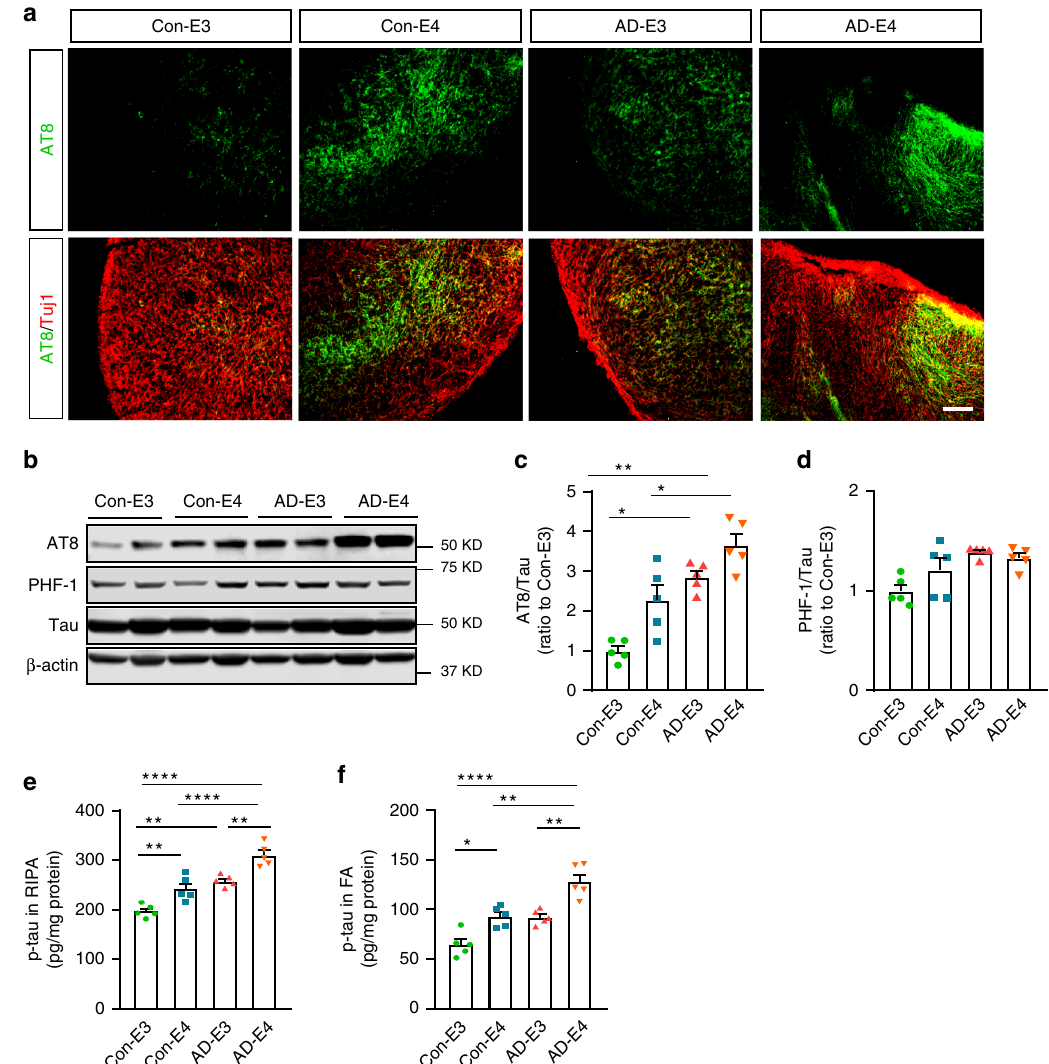
Fig. 4 APOE4 and AD status enhance p-tau levels in iPSC-derived cerebral organoids. Cerebral organoids were subjected to analyses by immunostaining, western blotting, and ELISA at week 12. a Representative images of the immunostaining for p-tau with AT8 (Ser202/Thr205) antibody. Scale bar: 100 μ m. b – d Total tau and p-tau levels in the RIPA lysates of 4 – 5 cerebral organoids per line were analyzed by western blotting and quanti fi ed. The p-tau levels detected by AT8 antibody ( c ; APOE4: p = 0.0037, AD: p = 0.0010, APOE4 x AD p = 0.6128, Con-E3 vs. AD-E3: p = 0.0290, Con-E3 vs. AD-E4: p = 0.0010, Con-E4 vs. AD-E4: p = 0.0273) and PHF1 (Ser396/Ser404) ( d ; APOE4: p = 0.3742, AD: p = 0.0404, APOE4 x AD: p = 0.1823) were normalized to total tau. e , f Amounts of p-tau in the RIPA fraction ( e ; APOE4 : p < 0.0001, AD: p < 0.0001, APOE4 x AD: p = 0.7063, Con-E3 vs. Con-E4: p = 0.0029, Con-E3 vs. AD-E3: p = 0.0015, Con-E3 vs. AD-E4: p < 0.0001, Con-E4 vs. AD-E4: p < 0.0001, AD-E3 vs. AD-E4: p = 0.0010) and the FA fraction ( f ; APOE4 : p < 0.0001, AD: p = 0.0005, APOE4 x AD: p = 0.4038, Con-E3 vs. Con-E4: p = 0.0121, Con-E3 vs. AD-E4: p < 0.0001, Con-E4 vs. AD- E4: p = 0.0024, AD-E3 vs. AD-E4: p = 0.0012) from 4 to 5 cerebral organoids per line were measured by ELISA. Data were normalized to individual total protein concentration. All data are expressed as mean ± SEM ( N = 5). ANCOVA for APOE4 , AD status, and APOE4 x AD status was performed by including sex, sampling age, and source of iPSCs as co-variables, which was followed by two-sided Tukey – Kramer tests to compare between the groups with two factors ( APOE4 and AD status). * p < 0.05, ** p < 0.01, **** p <